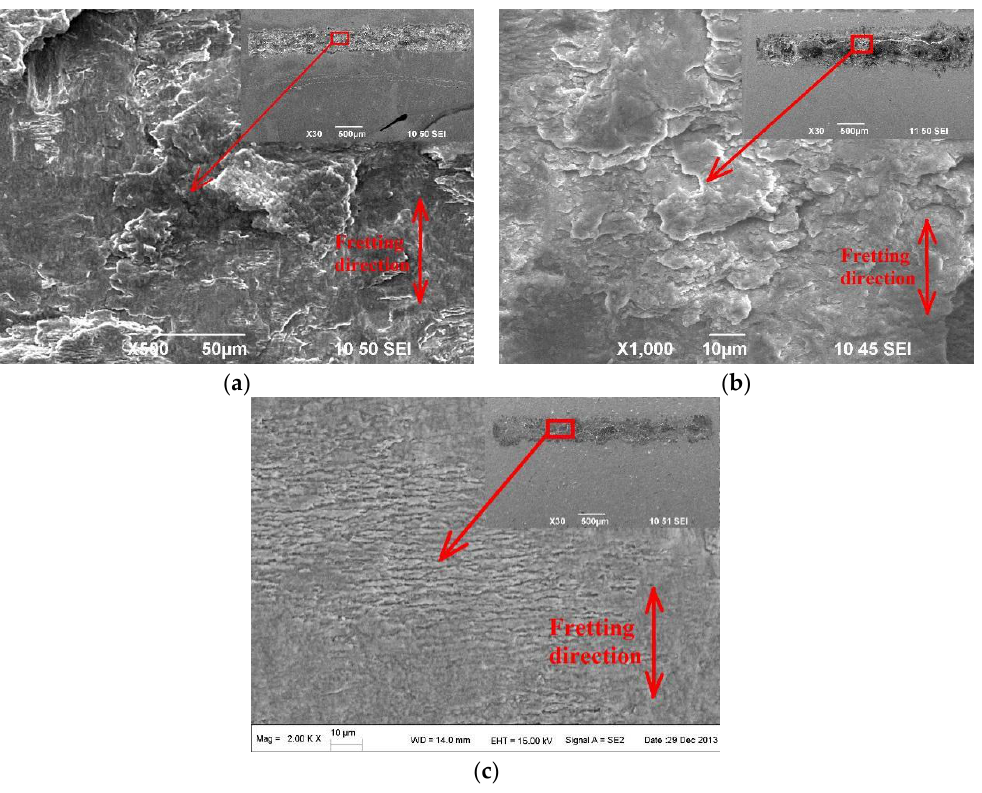
Figure 15. Morphology of FW tracks for different modified specimens. ( a ) Ti6Al4V alloy base; ( b ) ZrN; ( c ) ZrN+SP.